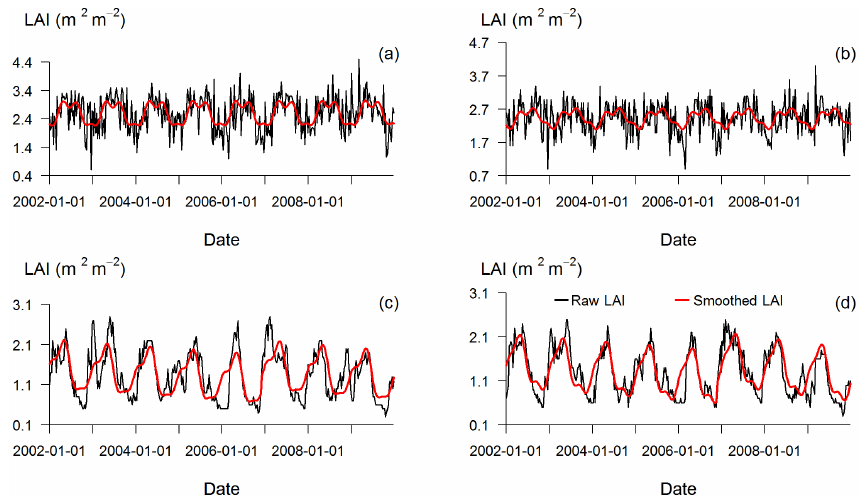
Figure 3. The 8-day raw-median LAI time series for evergreen forest (a) , tea (b) , grassland (c) and shrubland (d) sample sites. The raw- median LAI is smoothed using the Breaks For Additive Seasonal and Trend (BFAST) method (Verbesselt et al., 2010).